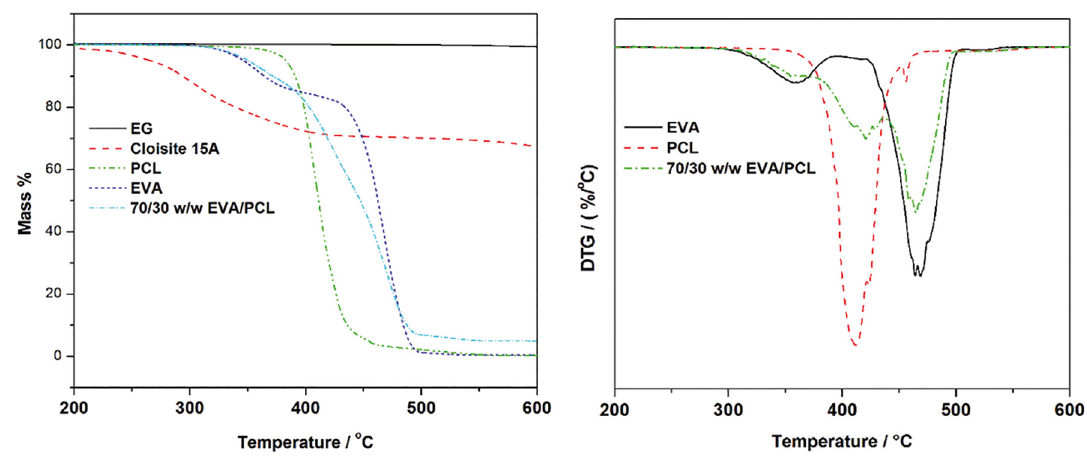
Figure 6: TGA of EG, Cloisite 15A, EVA as well as PCL and DTG curves